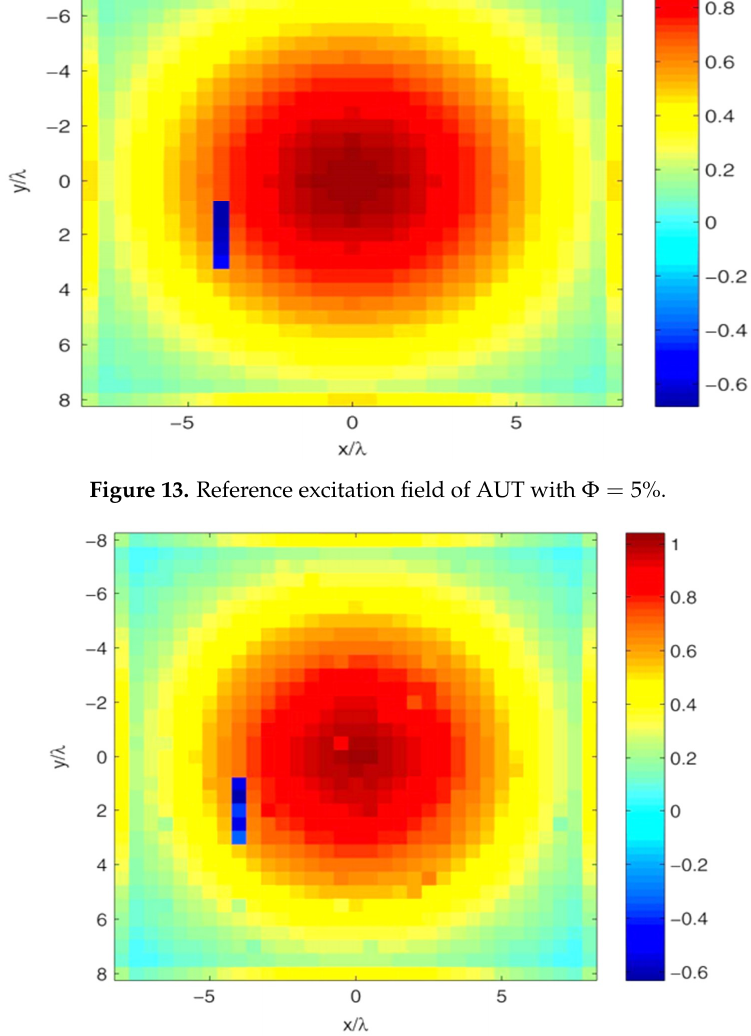
. Figure 16. Schematic of experimental set-up.